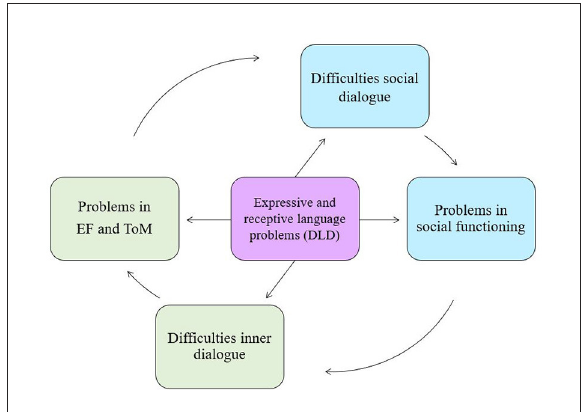
FIGURE1 Theoretical model of problems in social functioning, EF and ToM in DLD. Adapted from Vissers et al. (30),